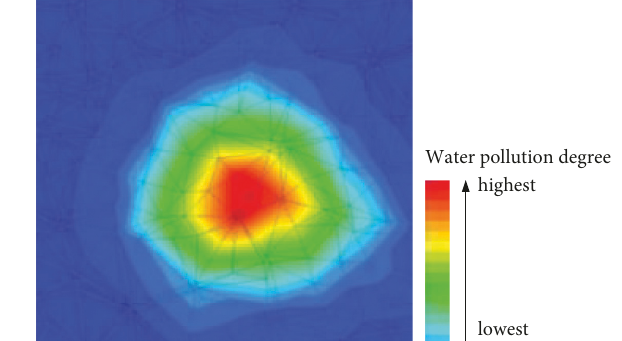
Figure 3: Overall overview of water pollution in the experimental